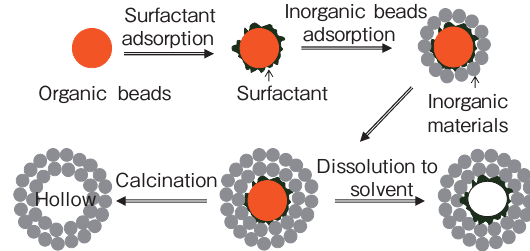
Fig. 1 Illustration for preparing inorganic hollow spheres with organic bead template 24) .